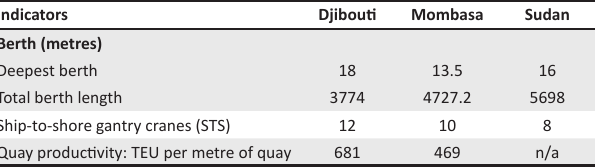
TABLE 3: Ports’ infrastructure and connectivity.